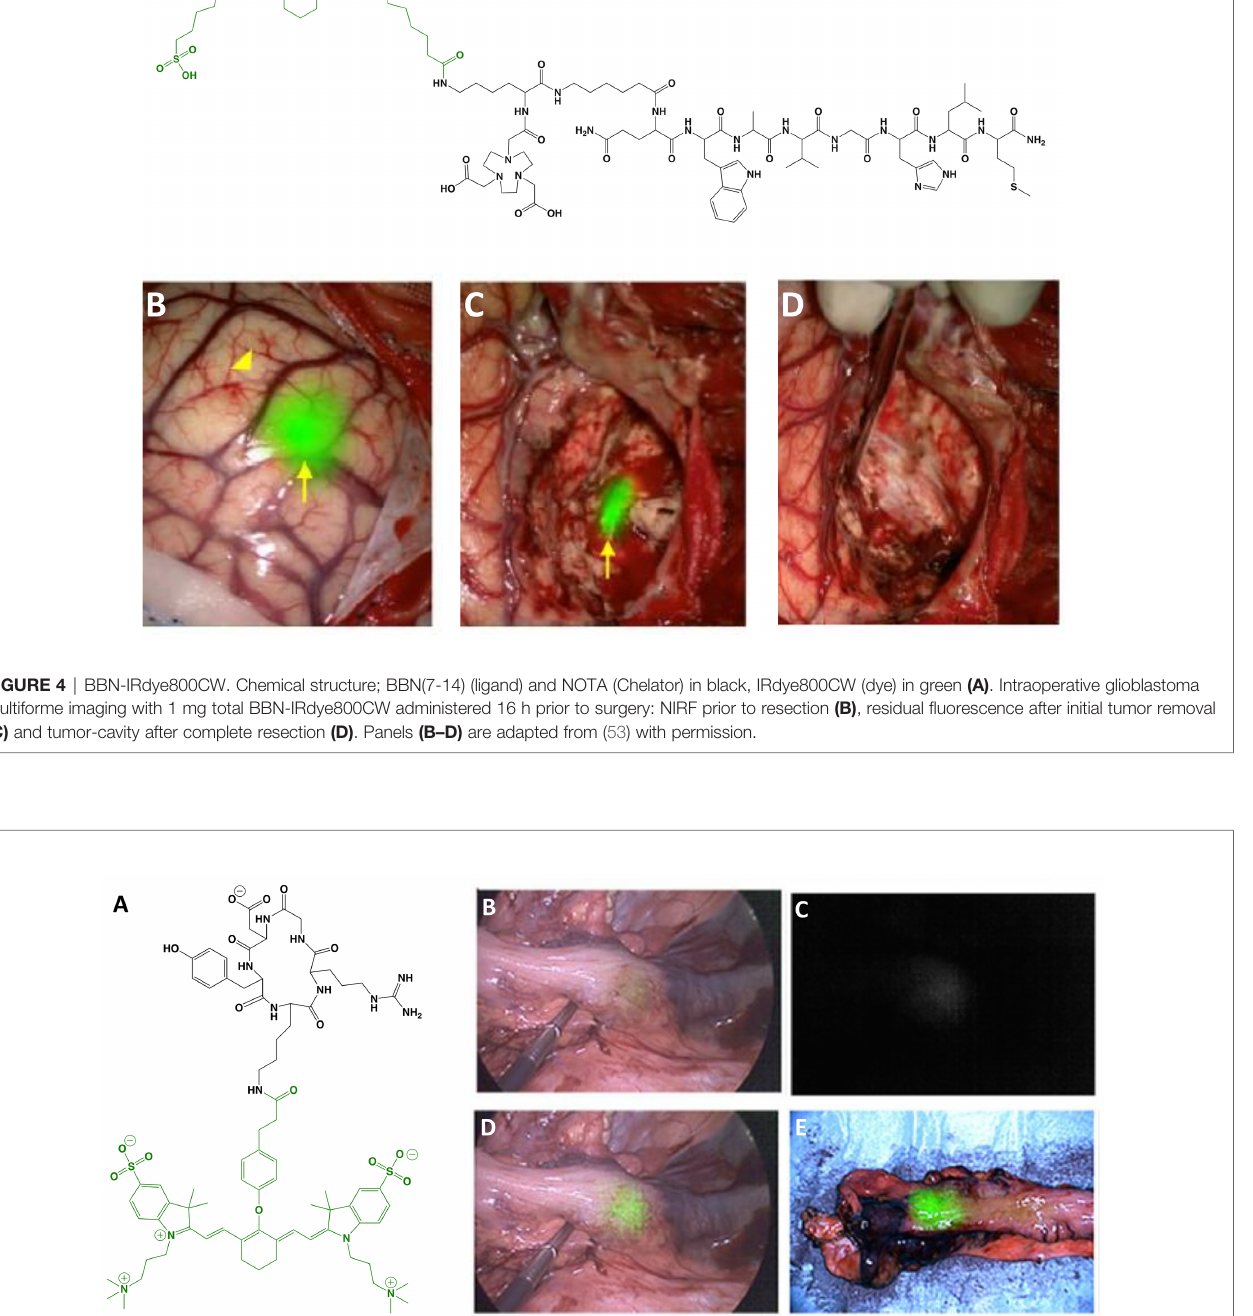
FIGURE 5 | cRGD-ZW800-1. Chemical structure; cRGDyK (ligand) in black, ZW800-1 (dye) in green (A) . Intraoperative colon cancer imaging with 0.05 mg/kg cRGD-ZW800-1 administered 18 h prior to surgery: white-light only (B) , NIRF only (C) and white-light with NIRF overlay (D) . Ex vivo imaging, white-light with NIRF overlay (E) . Panels (B – E) are adapted from (54) with permission.